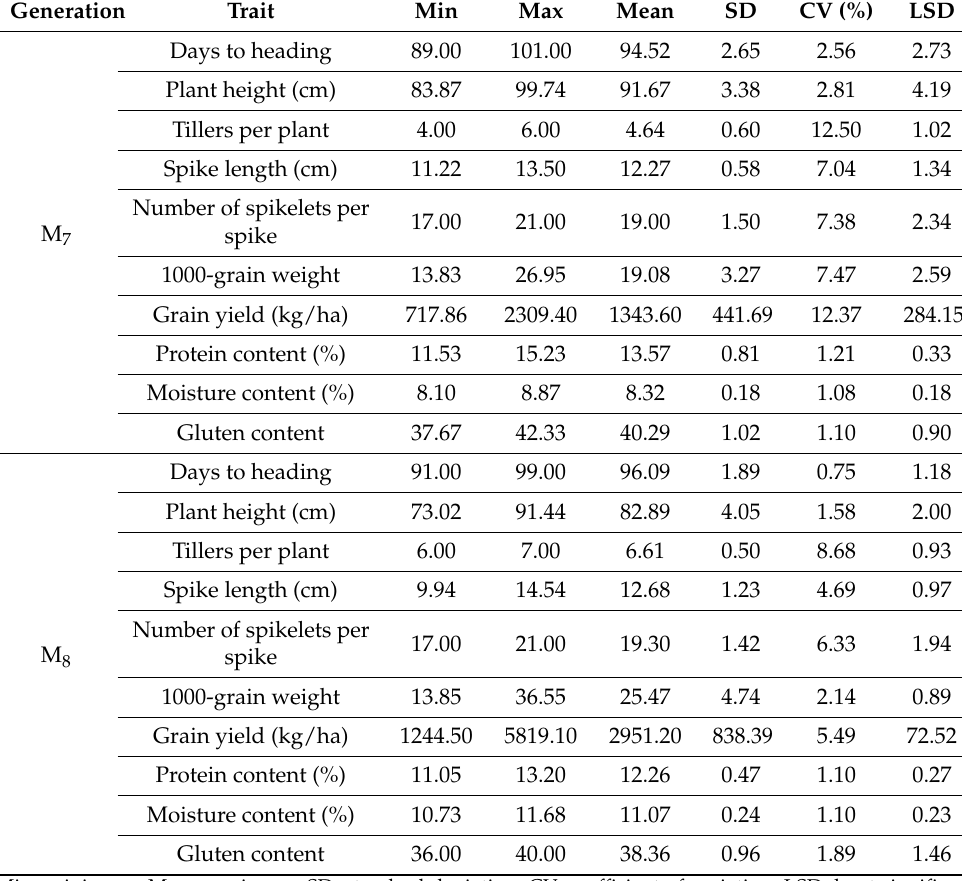
Table 4. Descriptive statistics of all traits calculated for 32 mutant lines and the wild type in M 7 and M 8 generations at the NIAB